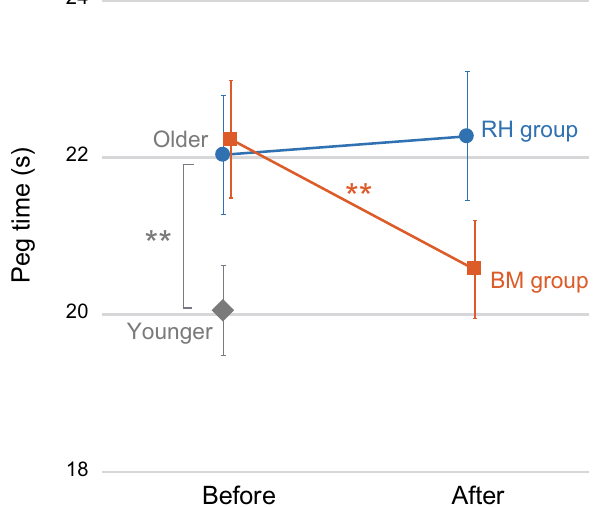
Figure 2. Peg time before (left) and after (right) the training. The orange squares indicate the average peg time in the BM group, the blue circles indicate that obtained in the RH group, and the gray diamond indicates that observed in the younger group. The error bars indicate the SEM. ** P ≤ 0.01. BM bimanual, RH right hand, SEM standard error of the